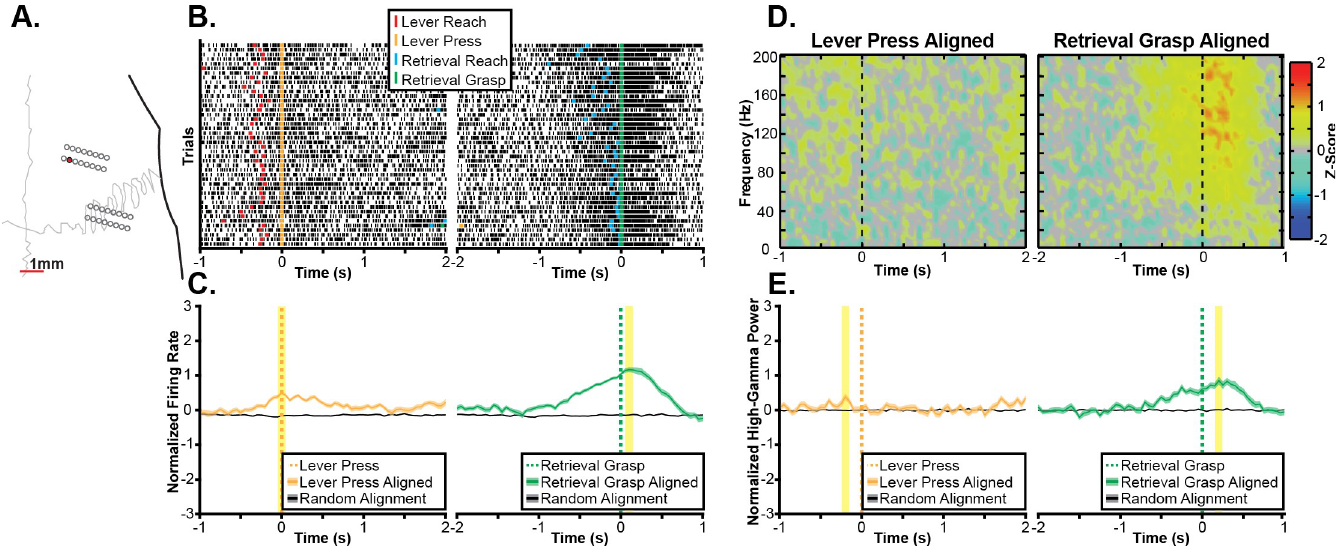
Fig 5. Exemplar grasp-related channel. A. Task-related neural activity is shown for an exemplar channel from the RFA array of Rat 2 as shown by the red electrode in the topographic plot. B. Raster plots show multi-unit spike times (black ticks) aligned to the lever press (left) and onset of the pellet grasp (right), showing an increase in firing rate correlated to the grasp onset. C. Multi-unit firing rates were estimated by counting spike times within 100 ms windows shifted by 50 ms between windows and then averaging across trials. Mean firing rates synchronized to the lever press and grasp were both significantly (p < 0.05) higher than expected by chance with a greater depth of modulation during the grasp. The statistically significant peak firing rates are indicated by the yellow highlighting. D. Spectral power changes are plotted aligned to the lever press (left) and pellet grasp (right). Spectral power changes were log transformed and z-scored relative to randomly selected time windows between trials, therefore, positive values indicated increases in spectral power, and negative values indicate decreases in spectral power. A broadband increase in spectral power in frequencies above 60Hz was observed for the pellet grasp. E. High-gamma band (70Hz-110Hz) power was significantly increased around both the lever press (left) and the pellet grasp (right) with a greater increase in high-gamma band power associated with the grasp. The statistically significant peak modulations of high-gamma band spectral power are indicated by the yellow highlighting.